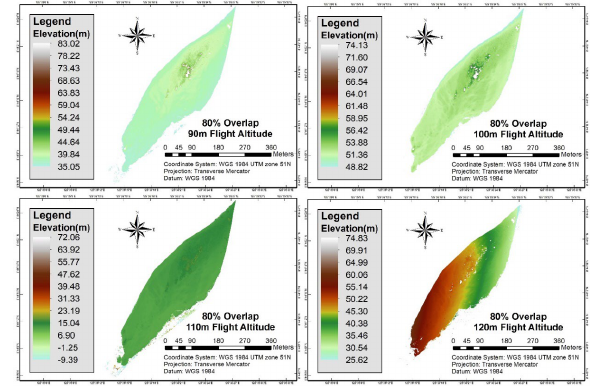
Figure 7 . Digital Terrain Models (DTMs) at 80% overlap generated using the acquired UAS data and disabled interpol ated setting. The white areas implied “no data” pixels.